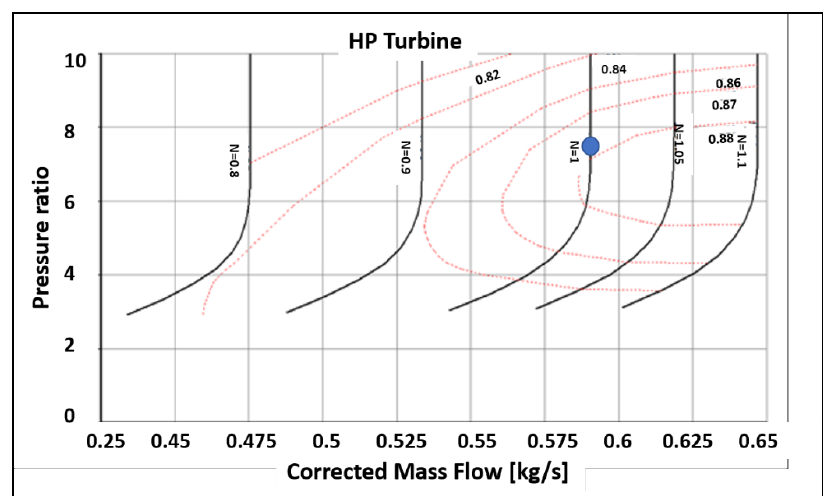
Figure 5. LP turbine map of the Engine1.